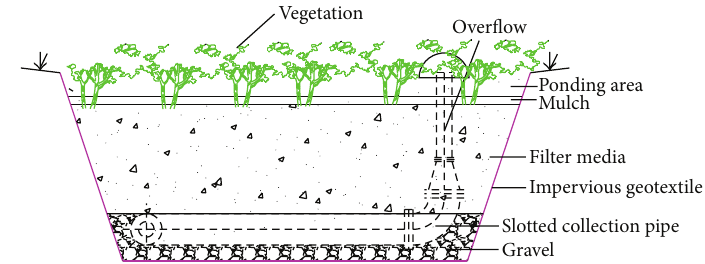
Figure 2: Schematic view of the bioretention